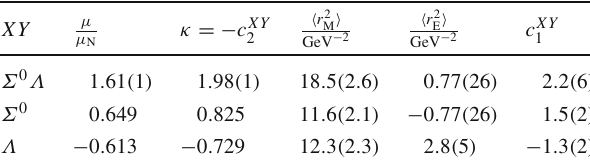
Table 1 Values of the form-factor parameters used in the numerical evaluations.Parameters κ = G M ( 0 ) arerelatedtomagneticmomentsof particles of mass M via μ = κ e ; for the Σ 0 Λ transition we put M = 2 M ˆ M .Themagneticmoments μ –takenfromRef.[43]–areexpressedwith M respect to the nuclear magneton μ N . Consequently, κ = μ μ . The M p N (cid:5) and (cid:4) r 2 (cid:5) arecalculatedbasedonthevaluesfromRef.[43]and radii (cid:4) r 2 M E using 1fm = ( 1 / 0 . 197327 ) GeV − 1 . Coefficients c XY are calculated 1 using Eq. (C.57) with M V = M